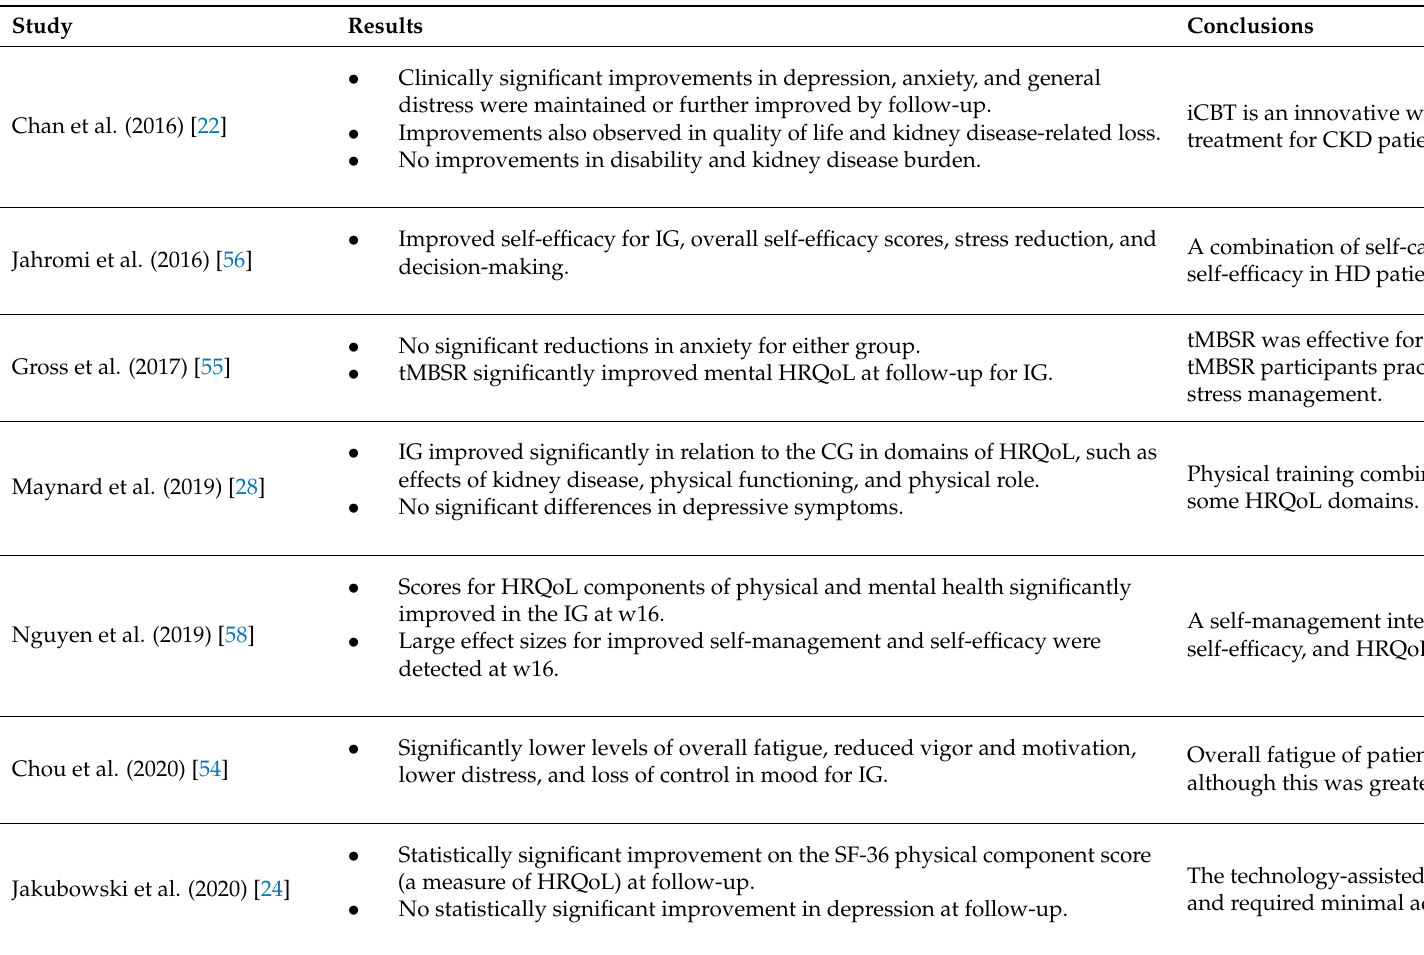
Table 4. Results and conclusions of included